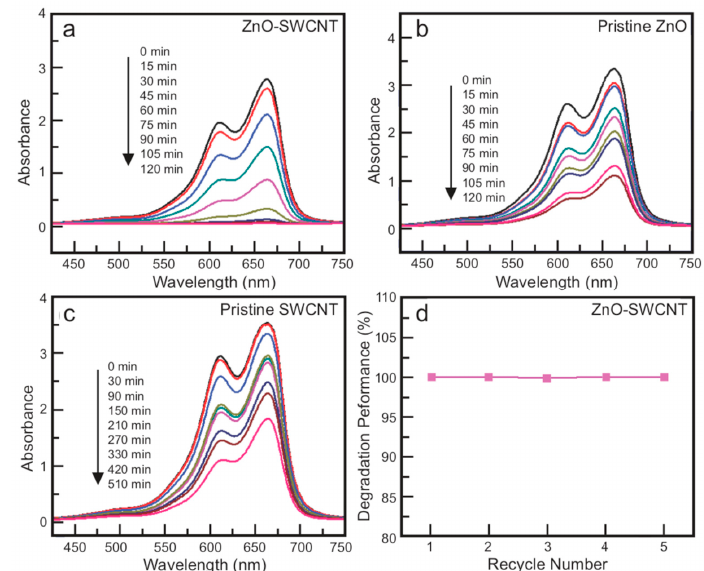
Figure 8. UV–vis absorption spectra of a methylene blue (MB) solution as a function of time in the presence of ( a ) the ZnO–SWCNT nanocomposite, ( b ) pristine ZnO nanorods, and ( c ) pristine SWCNTs. ( d ) Recycling performance of the ZnO–SWCNT nanocomposite.